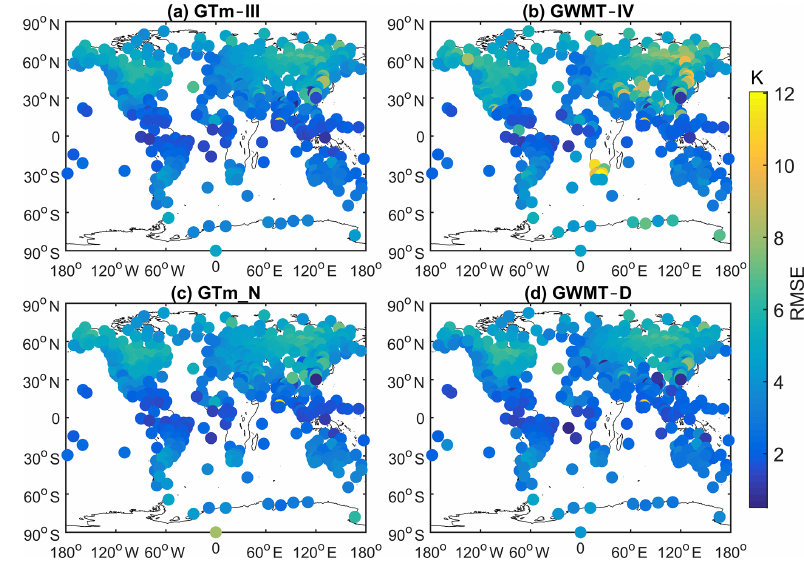
Figure 8. RMSE of model-derived surface T m in 2014 at 585 global radiosonde sites. Table 5. Statistics of the differences between model-derived and radiosonde-derived T m in various height intervals for the year 2014 at 585 global radiosonde sites (in K). The % column in this table is the percentage of radiosonde records within the height interval in that of all height